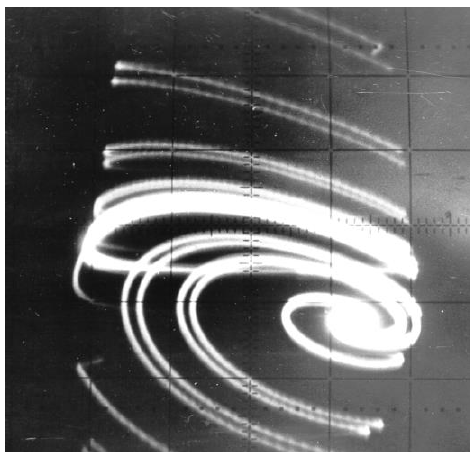
Fig. 2. Photograph of the phase portrait of the PLL system with a low-pass filter of the 3-d